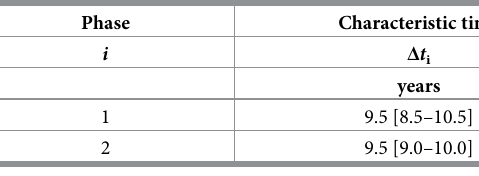
Table 2. Bi-logistic parameter